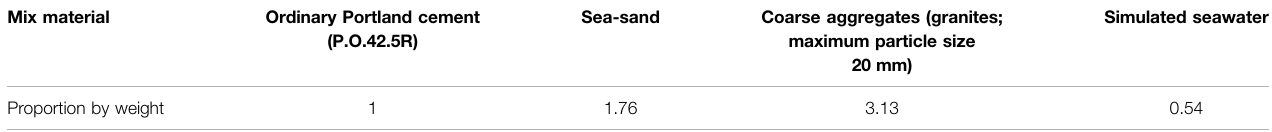
TABLE 3 | Mix proportions of seawater sea-sand